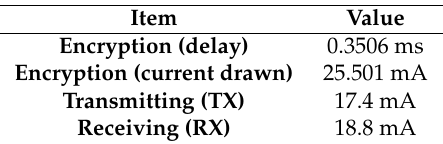
Table 4. Delay (ms) and current drawn (mA) by constrained devices when encrypting 16 bytes of data using AES-128 [18] and current drawn for the RX and TX radio